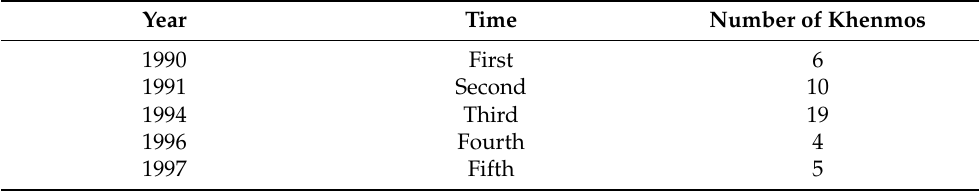
Table 1. Khenmos during Khenpo Jigme Phuntsok’s